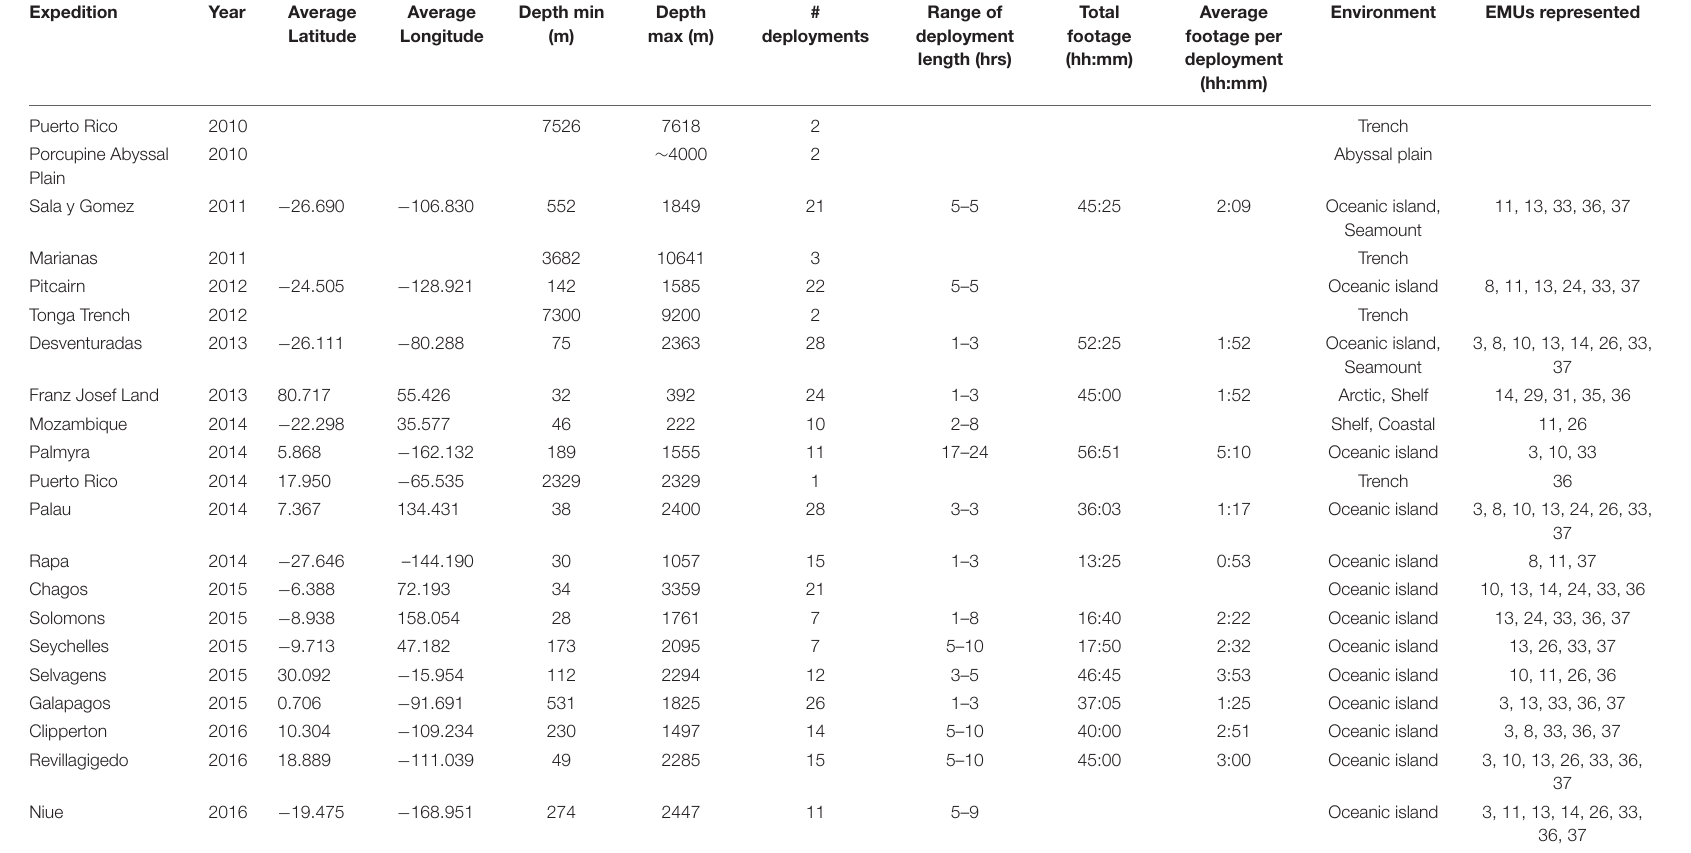
TABLE 1 | Expeditions on which NGS deep-sea camera systems have been